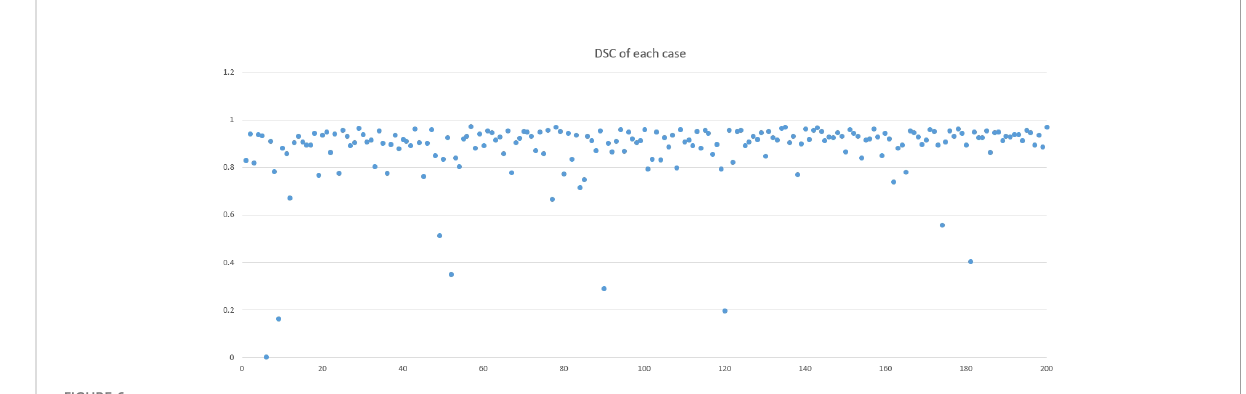
FIGURE 6 Dice similarity coef fi cient and intersection over union